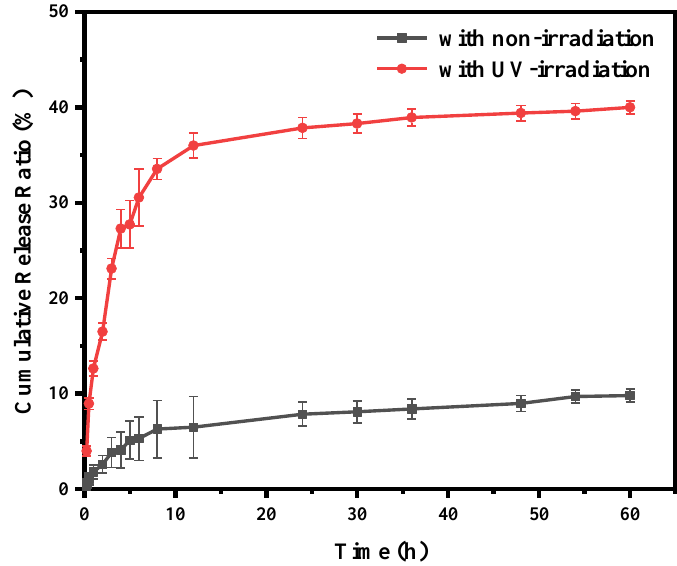
Figure 6. In vitro drug-release profiles of rhodamine B loaded PEG- b -PNSN 19 - co -PNPE 10 .